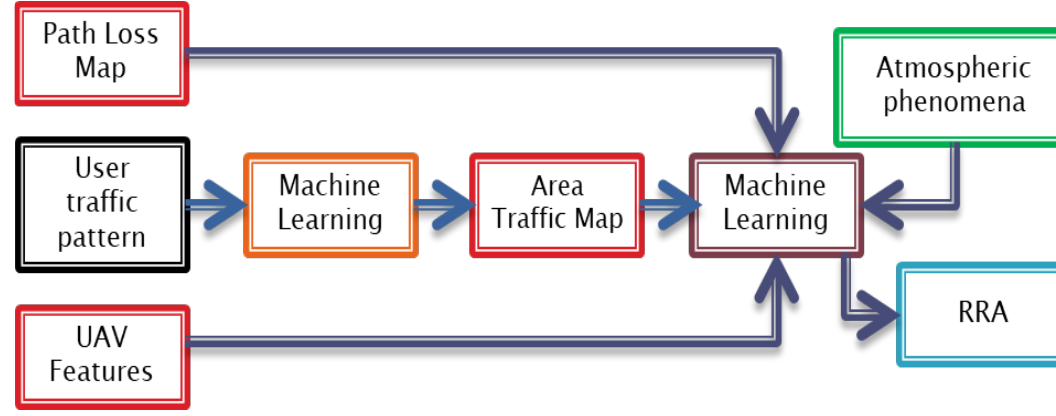
Figure 5. A block diagram view of RRA via ML.